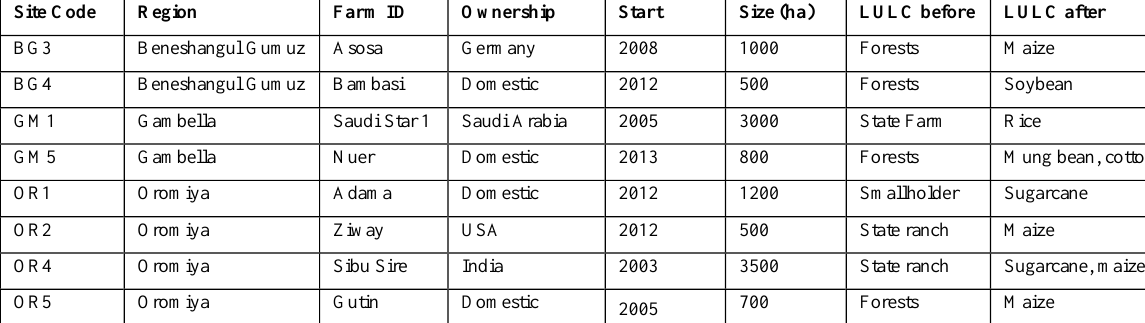
Table A1.1: LSLT